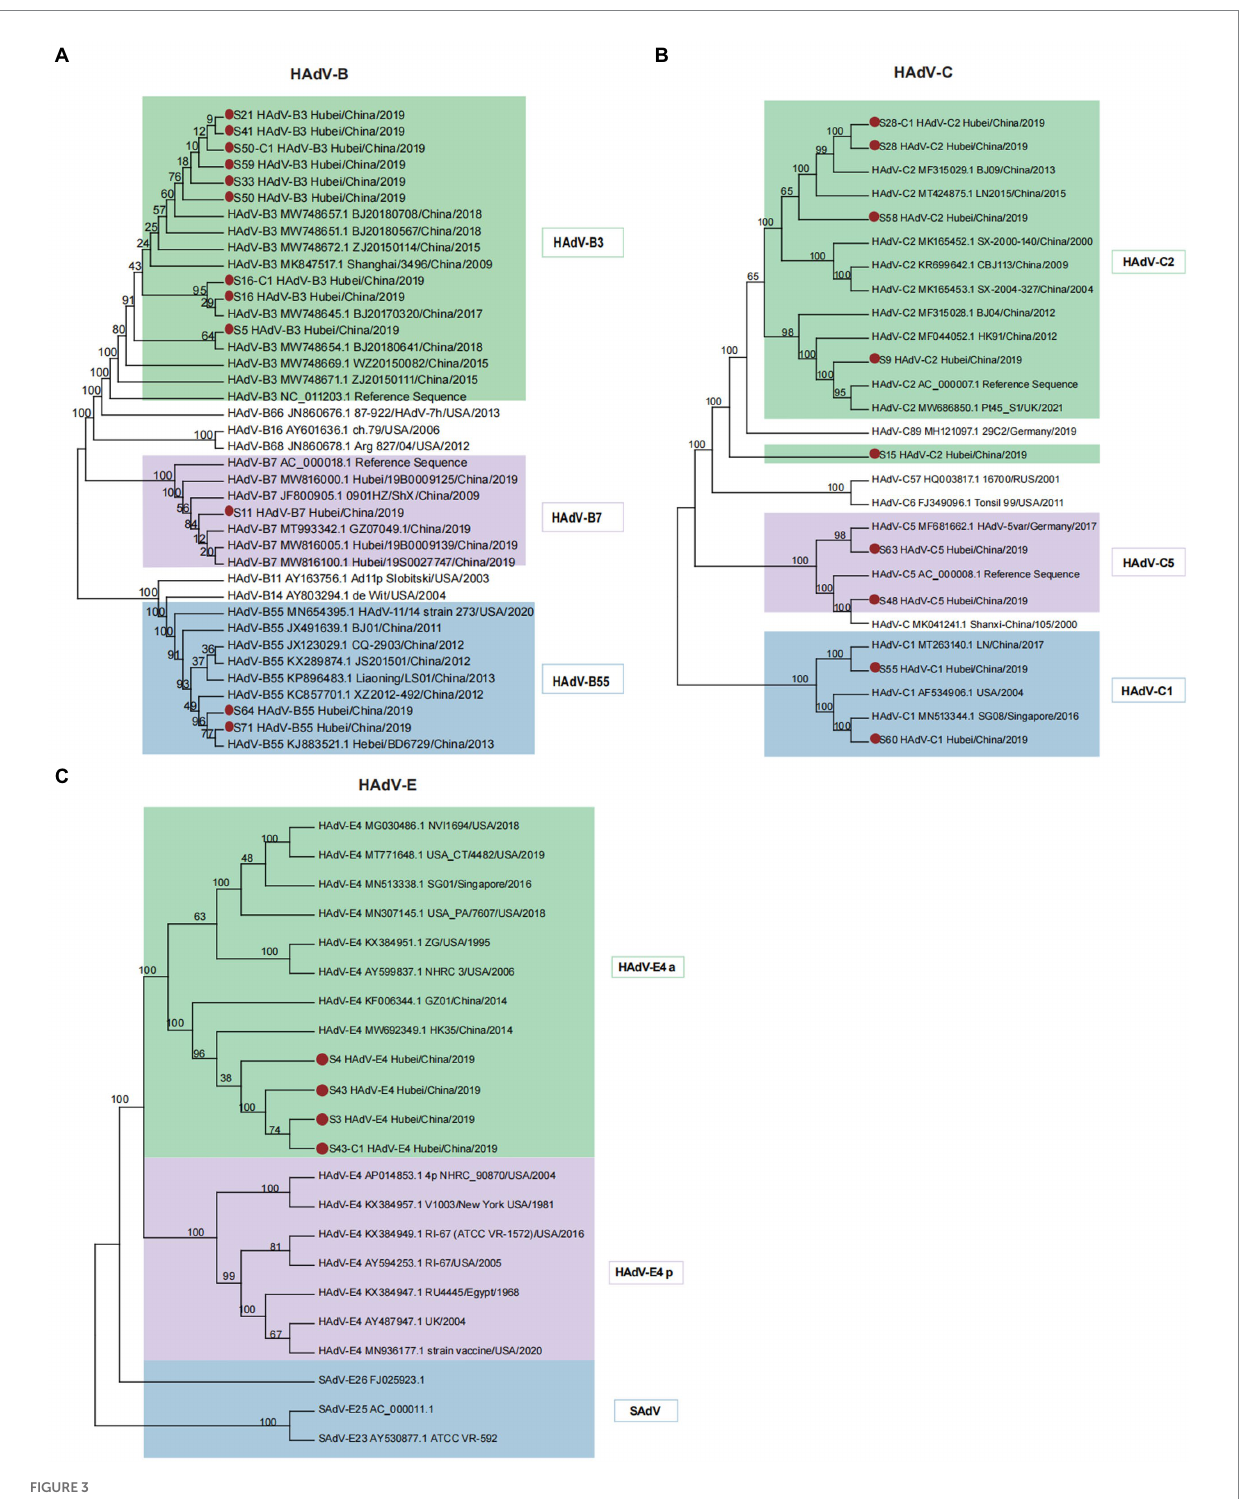
FIGURE 3 Phylogenetic analysis of HAdV-B, C, and E using the maximum likelihood method. (A) Phylogenetic tree of HAdV-B isolates. Different colored branches represent HAdVs isolated from different genotypes, designated HAdV-B3, B7, and B55. (B) Phylogenetic tree of HAdV-C isolates. Diverse colored branches represent HAdVs isolated from different genotypes, designated as HAdV-C1, C2, and C5. (C) Phylogenetic tree of HAdV-E isolates. Only one genotype (HAdV-E4) was identified. Two separable HAdV-E4 evolutionary lineages, prototype (p)-like and a-like, are highlighted in different colors. SAdVs were analyzed together to determine the phylogenetic relationships of HAdV-E4. Red dots denote new isolates collected in this